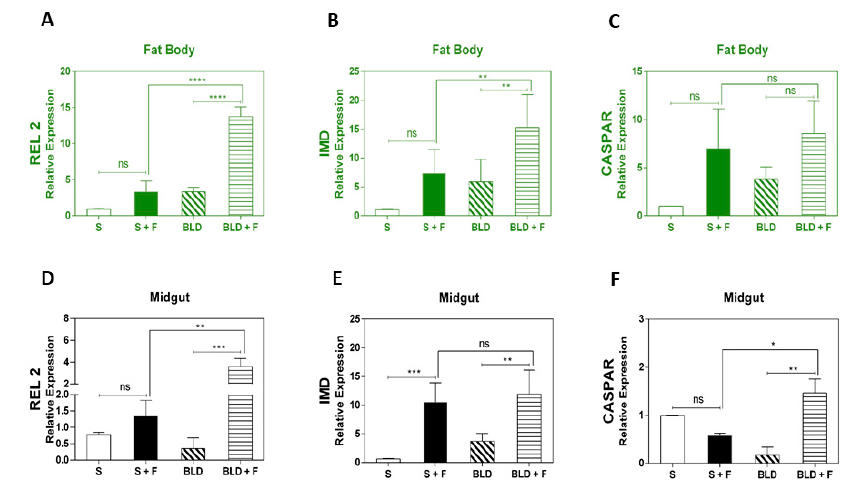
Figure 3. Expression analysis of IMD pathway marker genes after exposure of A. aegypti to M. anisopliae . Gene expression analysis of transcription factors REL2, IMD, and Caspar in the midgut and fat body of both sugar-fed and blood-fed insects at 48 h post-infection. The insects were fed with sucrose (10%) or mouse blood. Immediately after feeding, mosquitoes were sprayed with 0.05% Tween 80 solution, with or without M. anisopliae. Forty-eight hours post-infection, total RNA was extracted from mosquitoes, cDNA obtained, and RT-qPCR analyses subsequently performed. Each bar represents the results from a pool of 15 female mosquitoes. Results are the means of four independent experiments. The p -values from pair-wise comparisons (comparing Tween-treated to sugar-fed / blood-fed) were calculated using Student’s t -test and levels of significance were indicated for each bar (* p < 0.05; b: ** p < 0.01; *** p < 0.001; **** p < 0.0001). Negative controls were treated with 0.05% aqueous Tween